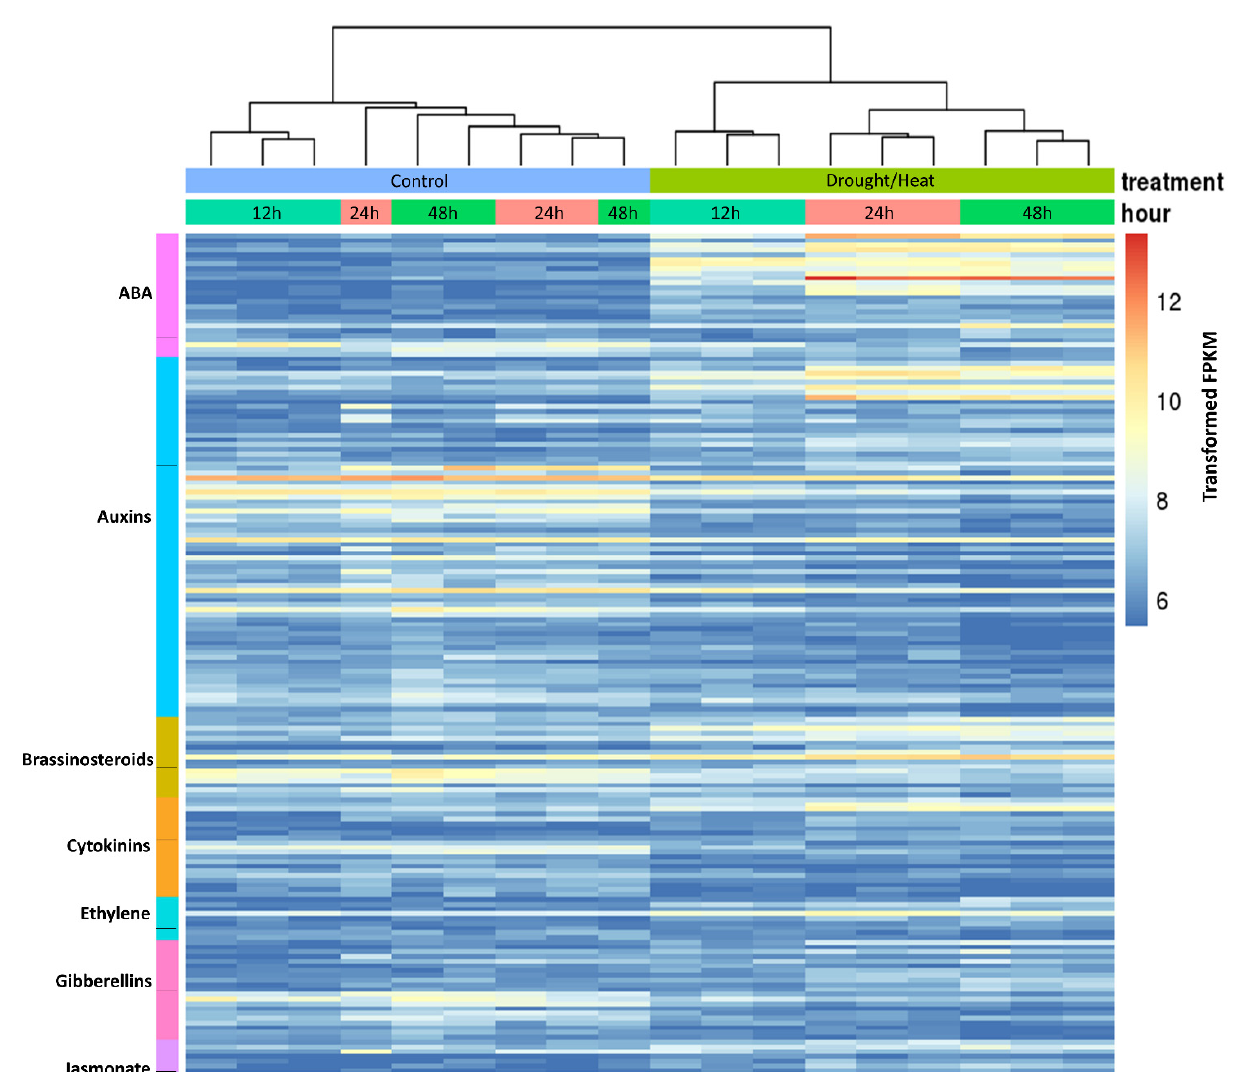
Figure 6. Heatmap of the 185 DEGs annotated as hormone related proteins that passed the differential expression filter of p-value 0.01, FDR 0.01, and log 2 -fold changes less than − 2 or greater than 2 in at least one time point. Values were transformed with variance stabilizing transformation. Gradient bar on the right side of the heat map represents the transformed value of fragments per kilobase per million reads (FPKM). Treatments (control and heat/drought) and treatment times of 12, 24 and 48 h are as shown. Gene groupings of hormone related DEGs are shown on the left axis. Horizontal lines on the left-axis separate the up- and down-regulated DEGs within each class. Samples (columns) are clustered using Euclidean distance and the dendrogram is shown at the top of the figure. For the specific expression data for hormone related DEGs represented in the heatmap, see Supplementary Table S3.